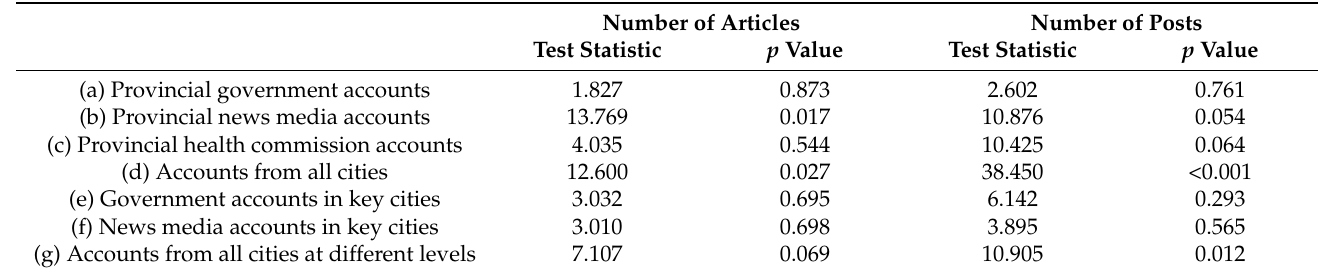
Table 1. Statistical analysis of emergency response effects. Number of Articles Number of Posts Test Statistic p Value Test Statistic p Value